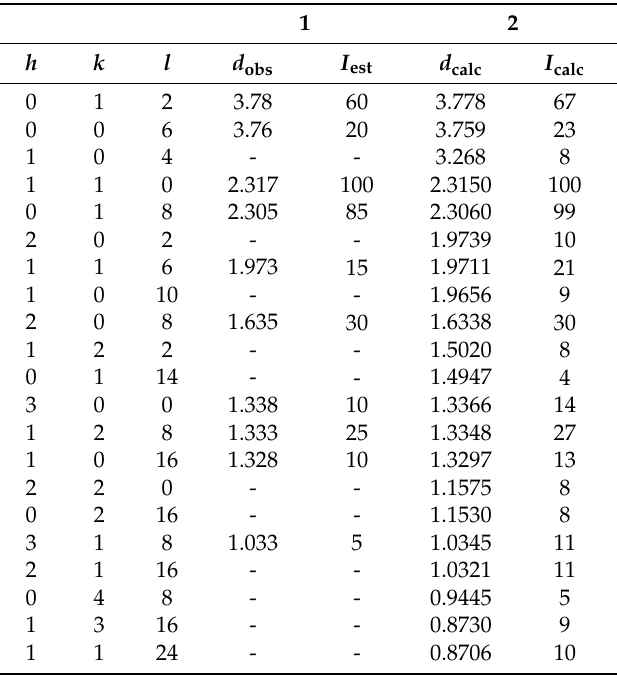
Table 3. Analytical data in wt.% for spiridonovite. 1 = observed diffraction pattern; 2 = calculated diffraction pattern obtained with the atom coordinates and occupancies reported in Table 5 (only reflections with I rel ≥ 4 are listed).